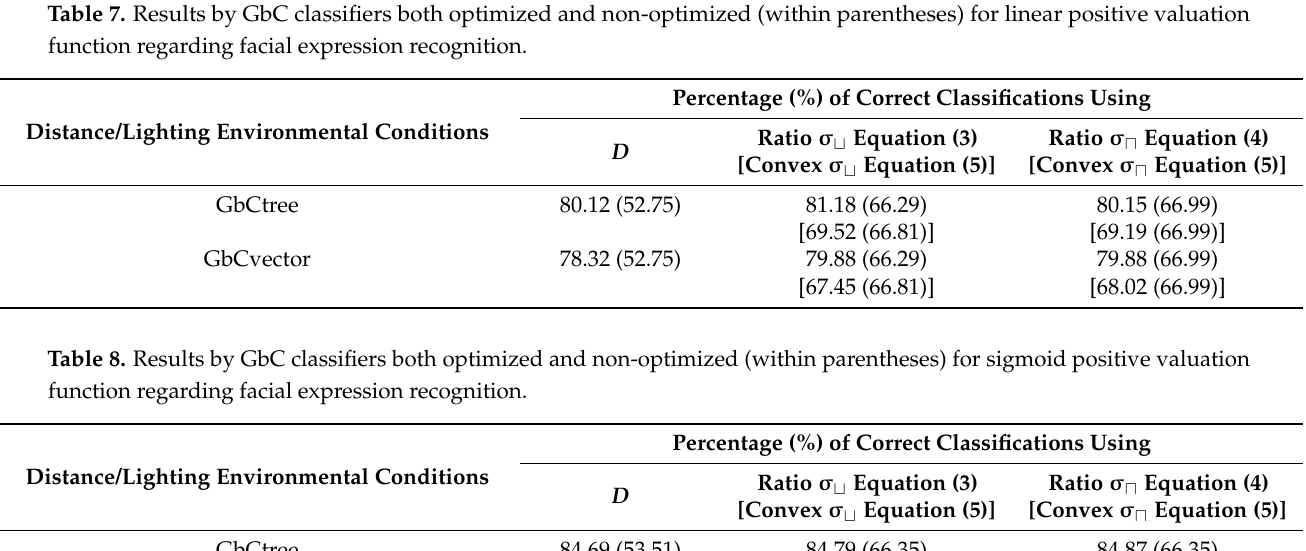
Table 7. Results by GbC classifiers both optimized and non-optimized (within parentheses) for linear positive valuation function regarding facial expression recognition.